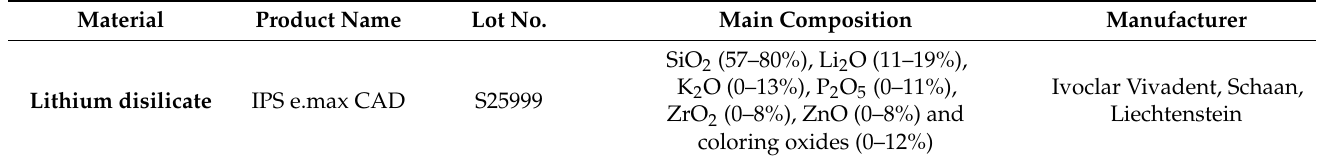
Table 1. Materials used in the